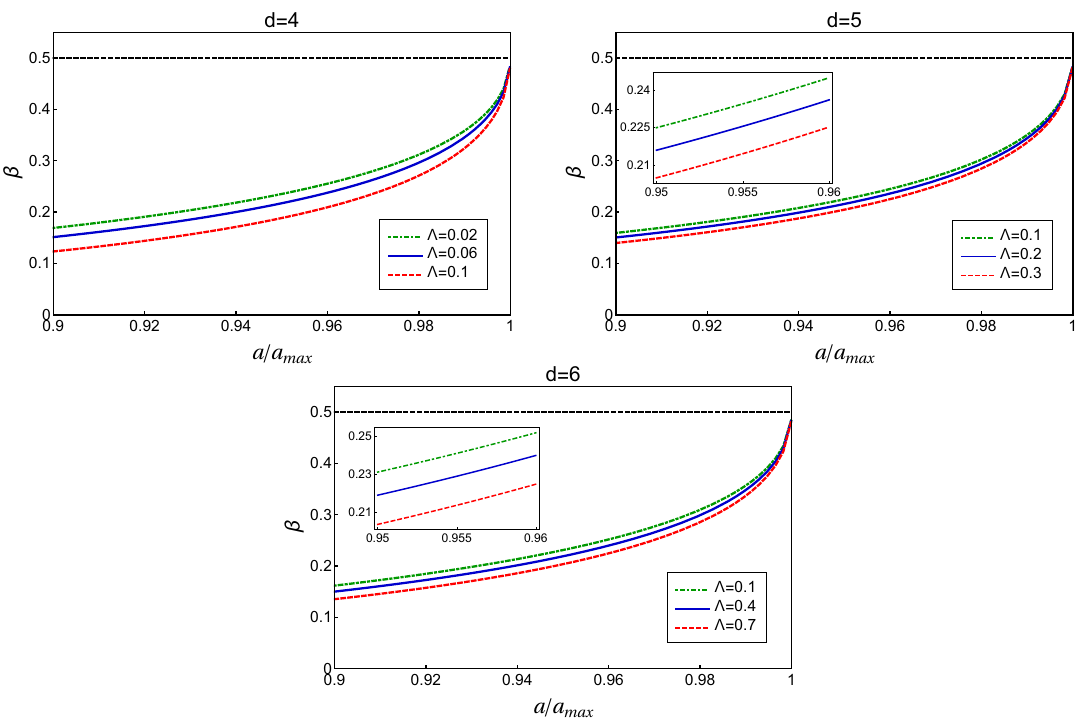
Figure 4 . The variation of the parameter (cid:12) with a=a max (with a max denoting the value of the maximal rotation parameter) for di(cid:11)erent values of (cid:3) in a d dimensional Kerr-de Sitter black hole has been presented. The plots associated with four and (cid:12)ve dimensional Kerr-de Sitter black hole have been presented at the upper-left and upper-right corners respectively, while that for six dimensional Kerr-de Sitter black hole is presented at the bottom. In each of these plot of the parameter (cid:12) , the black dashed line is associated with the curve corresponding to (cid:12) = 1 = 2. As evident these plots indicate that cosmic censorship conjecture is respected in any d-dimensional Kerr-de Sitter black holes. See text for more